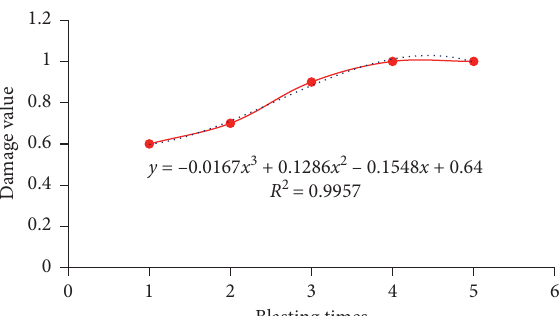
1 and the blasting times.